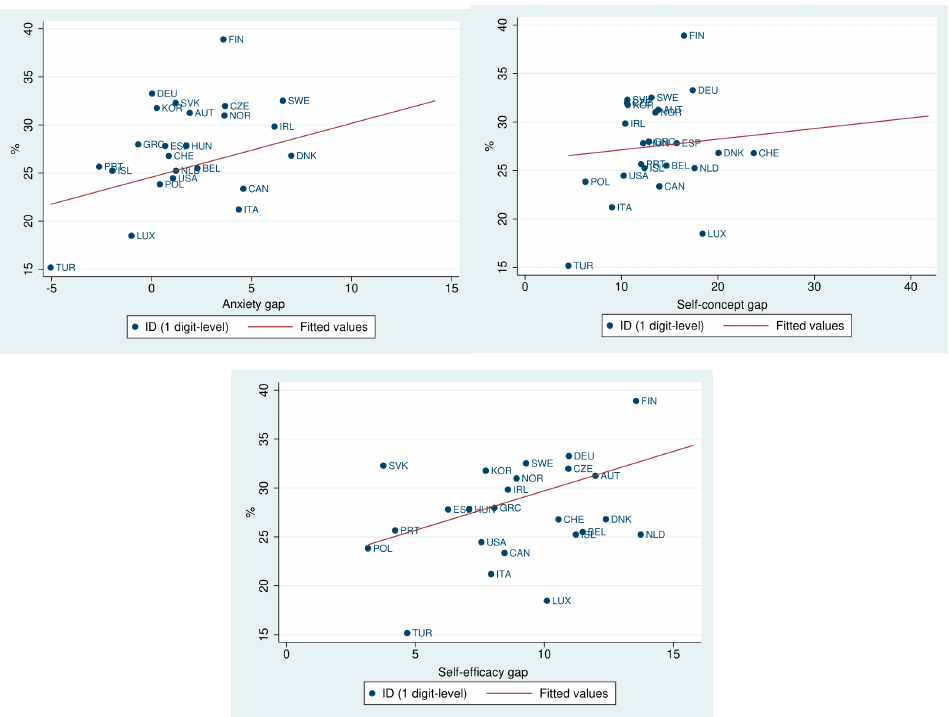
Figure A3. Gender Segregation and Math Self ‐ reported Belief.